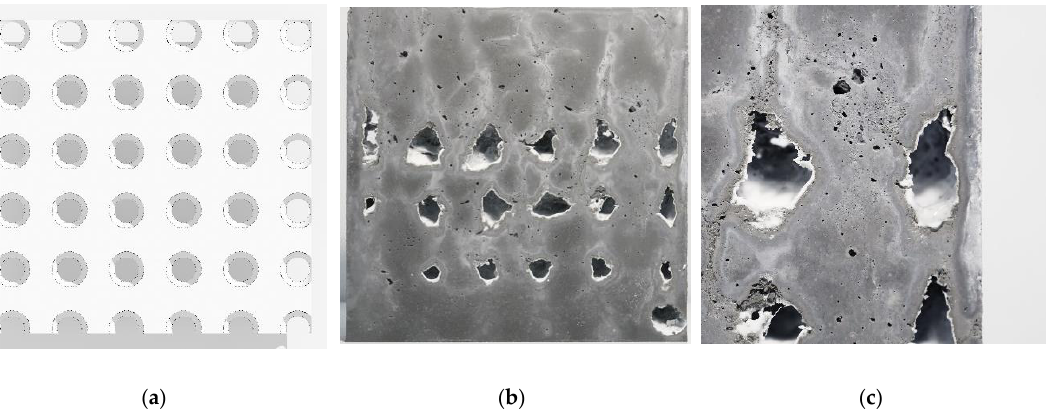
Figure 11. Initial experiment for calibration: ( a ) 6 × 6-point pattern; ( b ) result of the injection process; ( c ) closeup of the irregular voids with white skin and the unintended channels above.